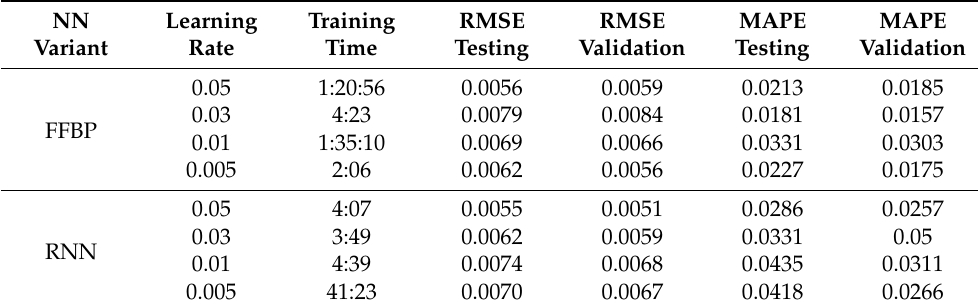
Table 8. Training and testing results of FFBPNN and RNN for case 5.